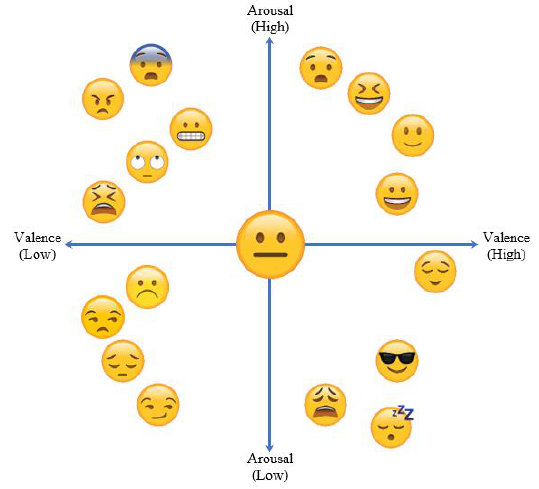
Figure 8. Valence – Arousal chart against various human emotions. Figure 8. Valence–Arousal chart against various human